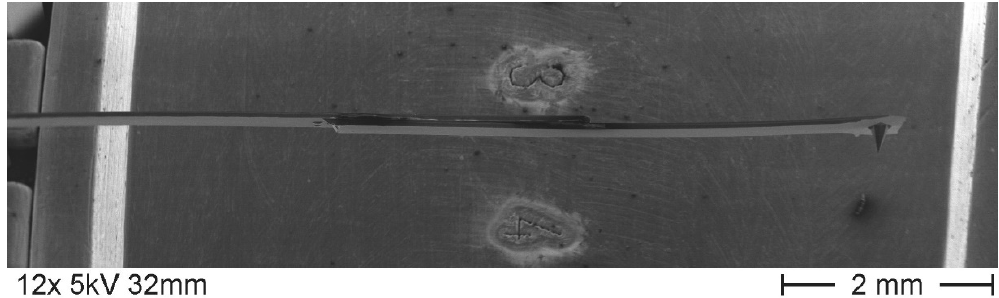
Figure 2. Extended microprobe of 7.5-mm length consisting of two 5-mm in length cantilevers glued to each other.